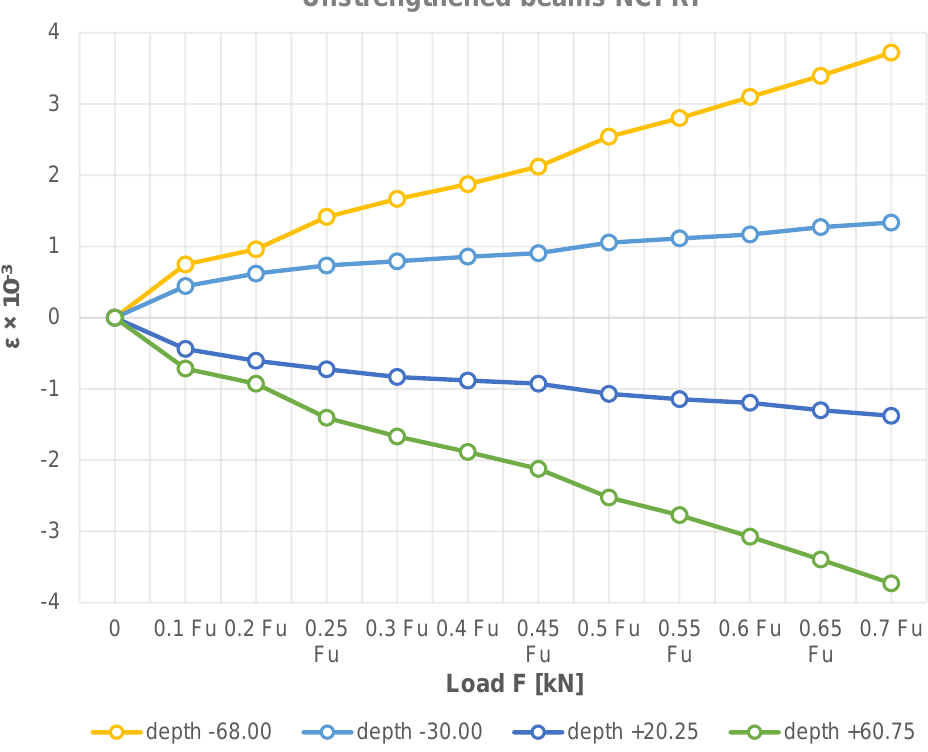
Figure 6. The distribution of deformations in timber beams at the section height.